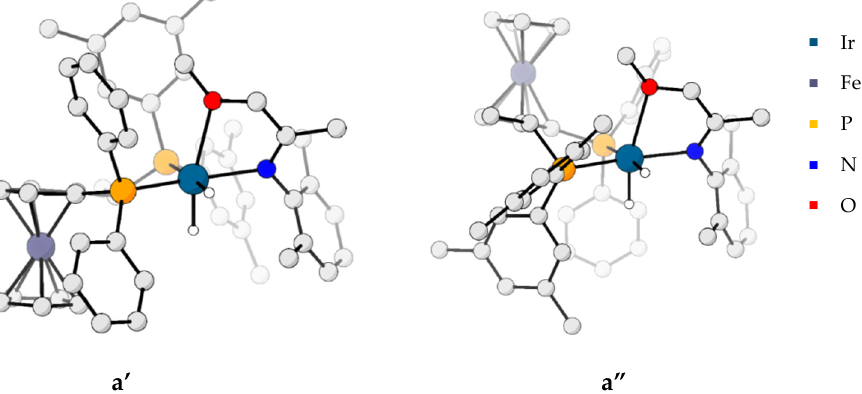
Figure 11 . Pro-( S ) diastereomers of complexes a, proposed intermediates in the inner-sphere mechanism that were prepared in previous work [11,12] . C-H hydrogens were omitted for clarity.